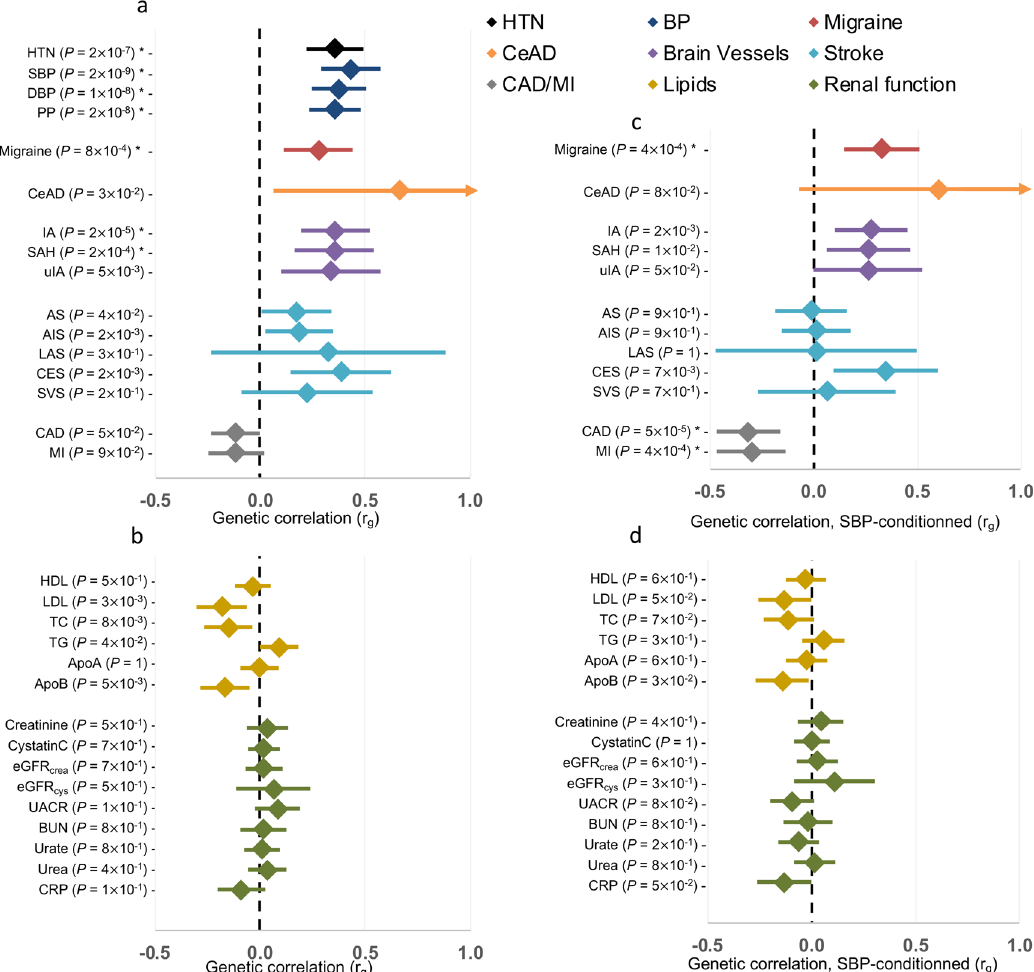
Fig. 5 Genetic correlations between FMD and other traits and diseases. a Genetic correlation obtained using LD Score analyses between FMD and vascular diseases and traits. HTN hypertension, BP blood pressure, SBP systolic BP (dark blue), DBP diastolic BP, PP pulse pressure, CeAD cervical artery dissection, IA intracranial aneurysm, all forms, SAH aneurysmal subarachnoid haemorrhage, i.e., ruptured intracranial aneurysm, uIA unruptured intracranial aneurysm, AS any stroke, AIS any ischaemic stroke, LAS large artery stroke, CES cardioembolic stroke, SVS small vessel stroke, CAD coronary artery disease, MI myocardial infarction. b Genetic correlation obtained using LD Score analyses between FMD and vascular diseases and metabolic traits. HDL high-density lipoprotein, LDL low-density lipoprotein, TC total cholesterol, TG triglycerides, ApoA apolipoprotein A, ApoB apolipoprotein B, eGFR estimated glomerular fi ltration rate (calculated with creatinine or cystatin), UACR urine albumin to creatinine ratio, BUN blood urea nitrogen, CRP C-reactive protein. c , d Genetic correlation results after FMD genetic association statistics were conditioned on systolic blood pressure. *Unadjusted P value of genetic correlation estimated from linkage disequilibrium score regression using a two-sided Wald test is below the multiple testing threshold for signi fi cance (1.6 × 10 − 3 for 31